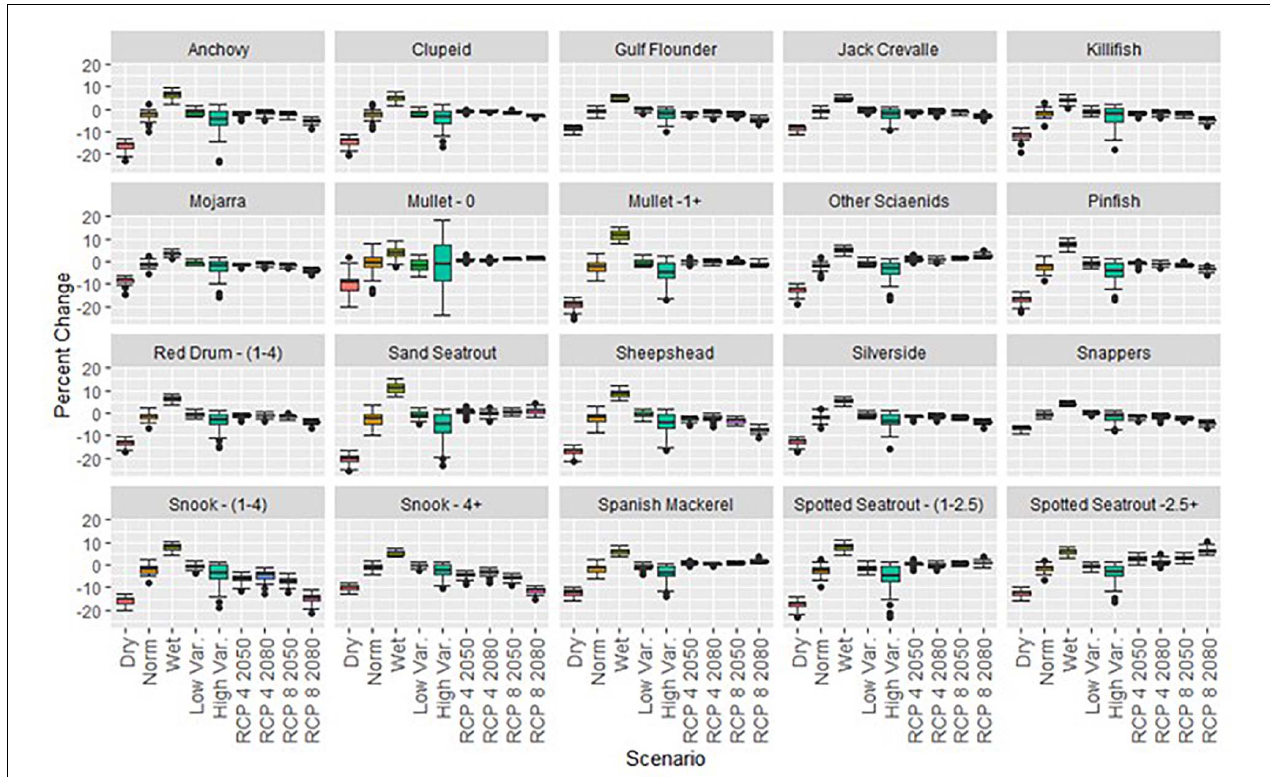
FIGURE 6 | Changes in biomass densities for all fish groups. Functional groups tended to exhibit greater biomass changes in dry scenarios than flood conditions. Values are presented as percent changes from status quo